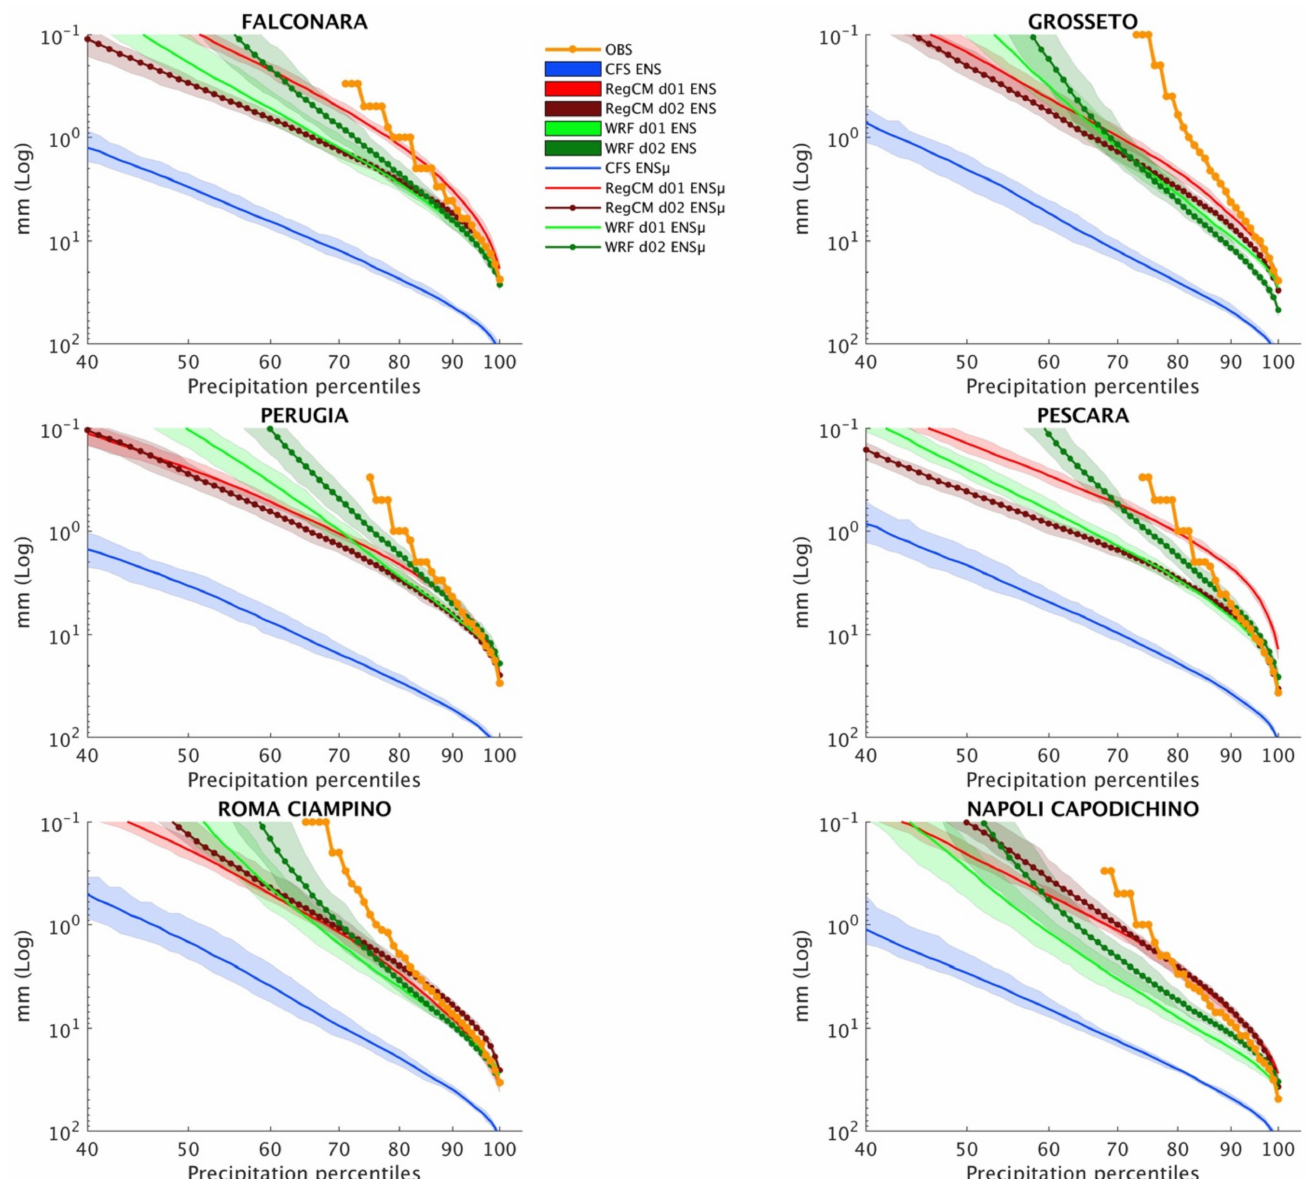
Figure 11. Point-scale evaluation of the percentile-based reference period precipitation. Differently from FIG. 9 on y -axis is reported precipitation physical values instead of bias. Orange dotted lines represent observed